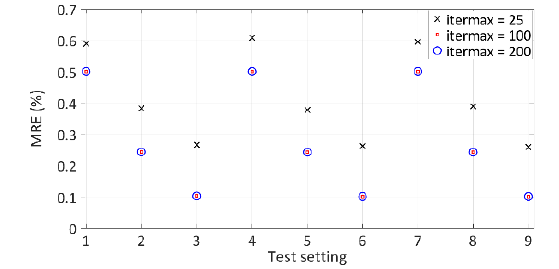
Figure 6: MRE of the surrogate model output variable using the adapted input variable.